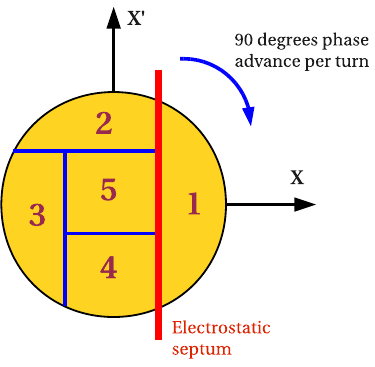
FIG. 6. Five slices in normalized phase space. Q x ¼ 6 : 25 corresponds to 90 (cid:2) phase advance per turn. As the C SPS ¼ 11 (cid:1) C PS , two consecutive PS extraction of five slices each are needed to fill the SPS completely.